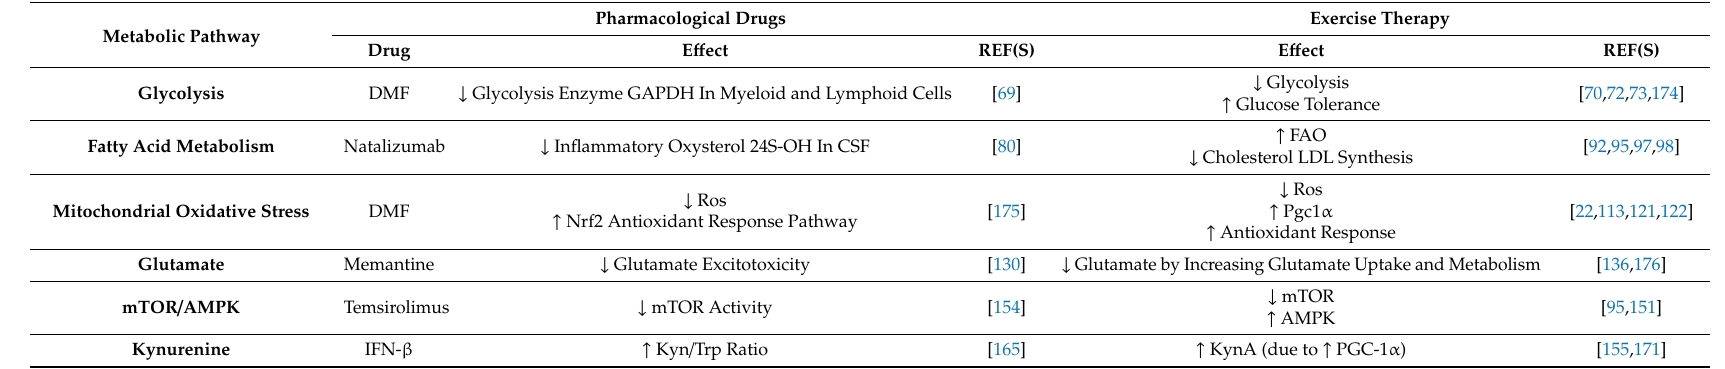
Table 1. Comparison of pharmacological therapies and exercise therapy in targeting metabolic pathways altered in